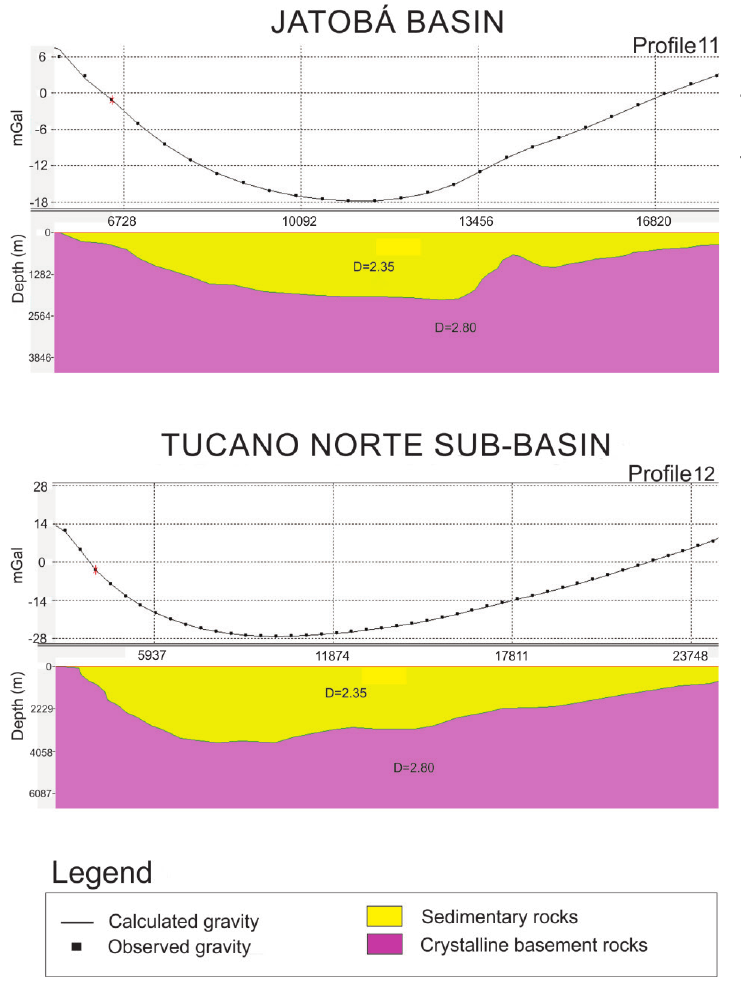
Figure 4. 2.5D density profiles of sections 11 and 12 (Jatobá Basin and Tucano Norte Sub-basin, respectively) modelled by the direct